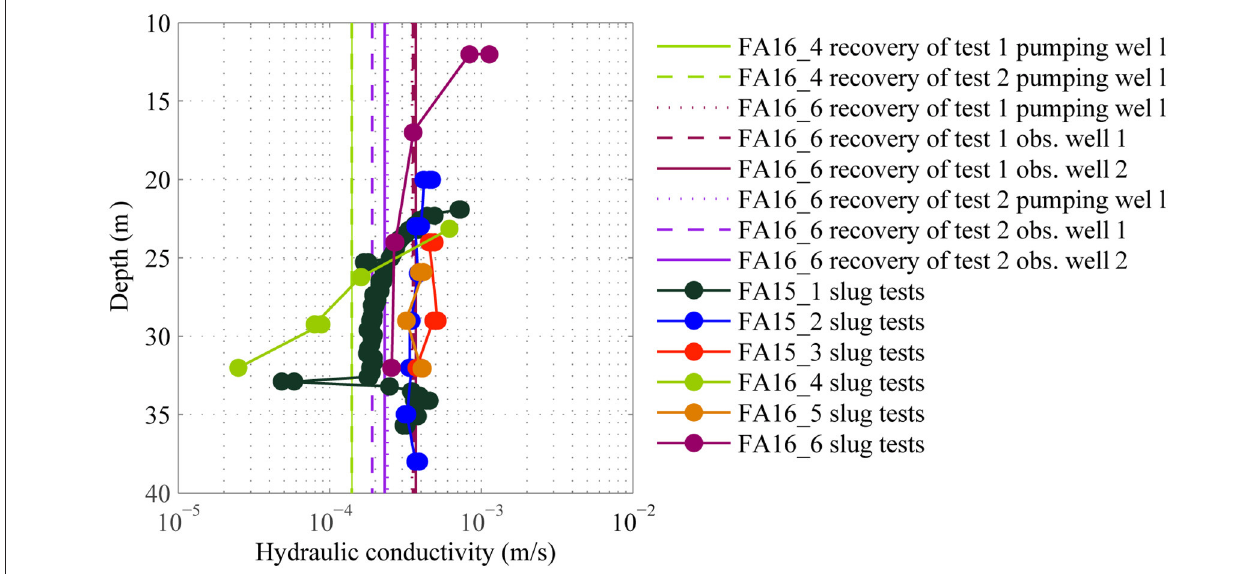
FIGURE 5 | Hydraulic conductivity across ∼ 10km and between 10–40m depth. Hydraulic conductivity estimates determined using the Hvorselv method for slug test data and the Theis method for aquifer test data. The slug test measurements were taken at specific depths while the aquifer test data are not depth-specific. Water level rise due to recharge during the aquifer tests has been removed, as has data from the pumping well at site FA16_4 (see Section Aquifer Tests). Data points are larger than standard error of